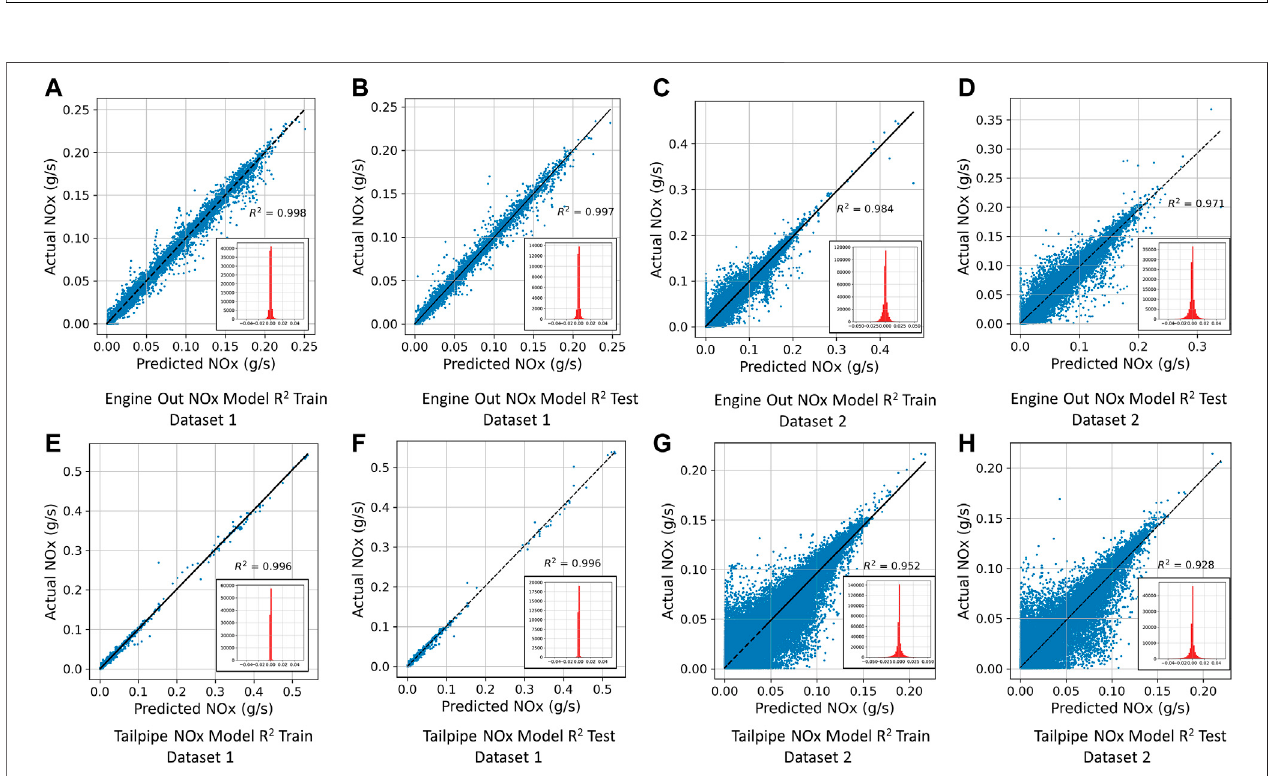
FIGURE3| EvolutionofMSEand R 2 curvesovertrainingandvalidationdata(AllModels). (A) EngineOutNOxLossand R 2 Dataset1. (B) TailpipeNOxLossand R 2 Dataset 1. (C) Engine out NOx Loss & R 2 Dataset 2. (D) Tailpipe NOx Loss and R 2 Dataset 2